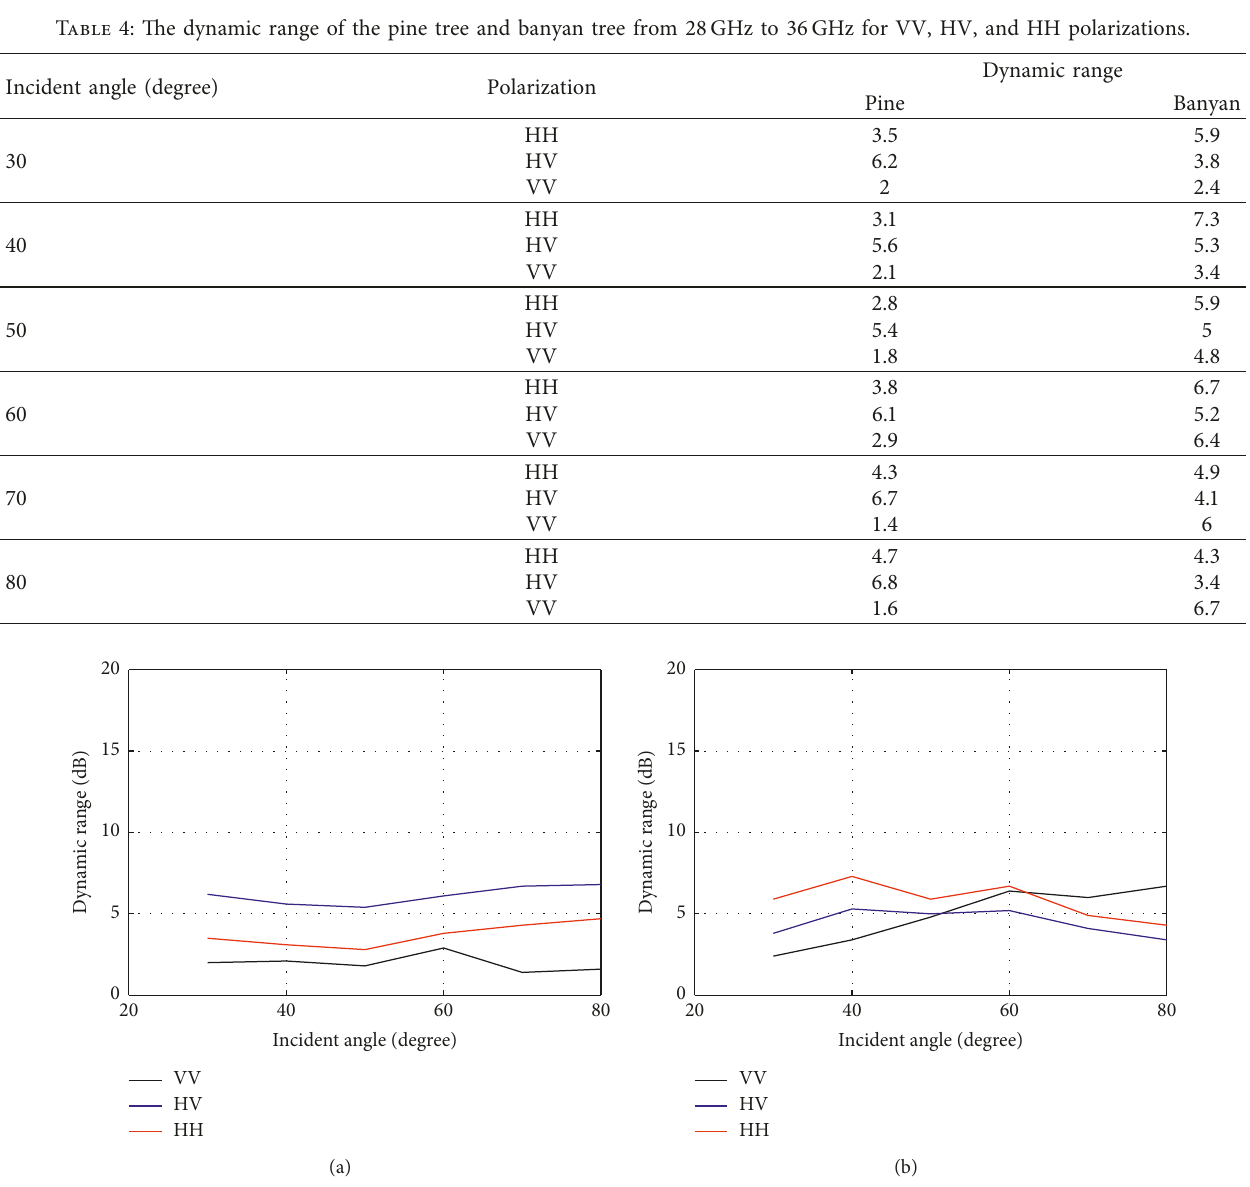
Figure 8: The dynamic ranges of angular response in (a) pine trees and (b) banyan